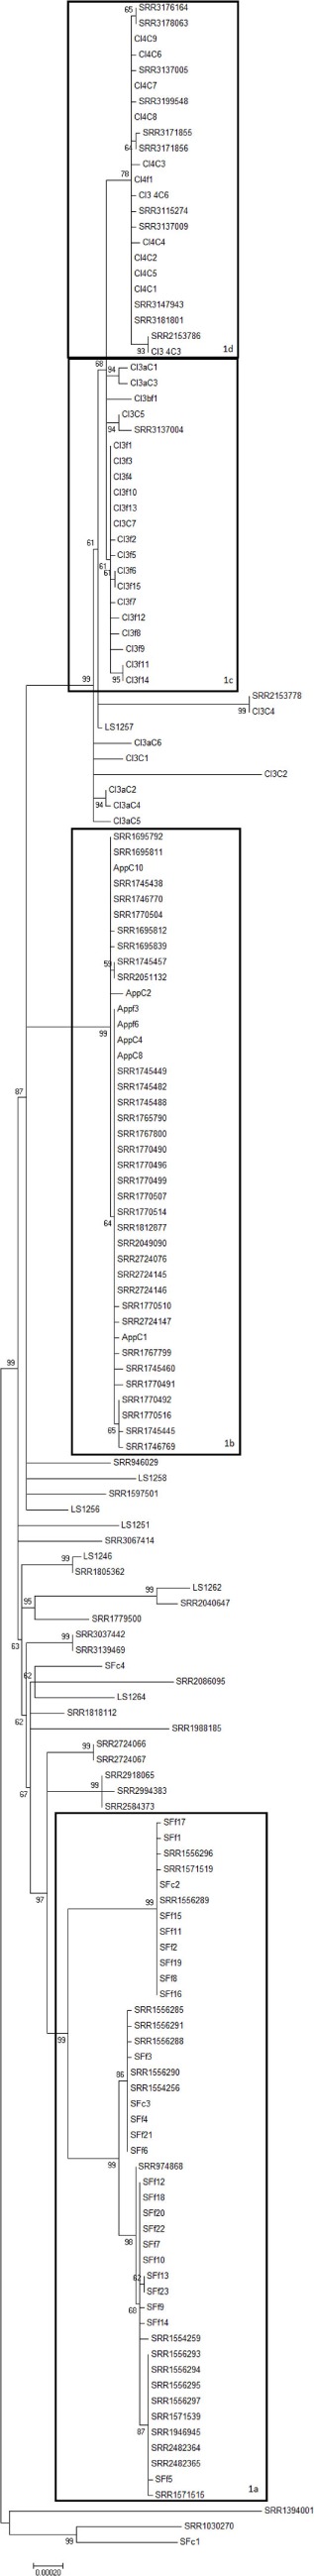
A maximum likelihood tree of members of 4bV Clade 1 derived from SNP alignment file generated using the CFSAN SNP Pipeline with bootstrapping (n = 1,000). Strains linked to specific outbreaks are renamed as noted in Table S1 in Supplementary Material for ease of reference. Subclades within Clade 1 are indicated. The scale bar indicates distance as assessed by the Tamura–Nei method.